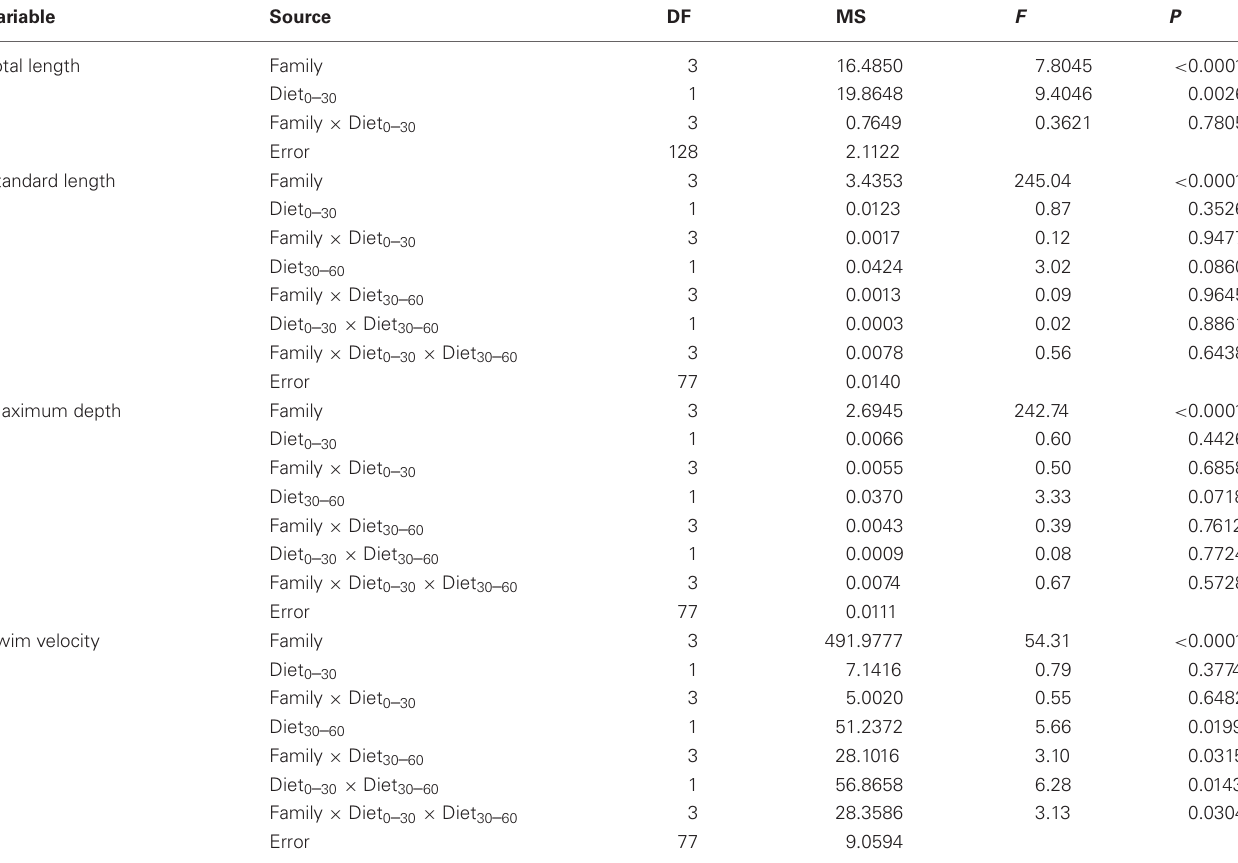
Table 1 | ANOVA results for total length (TL; n = 136), standard length (SL; n = 93), maximum depth (MD; n = 93), and swim velocity ( n = 93). Variable